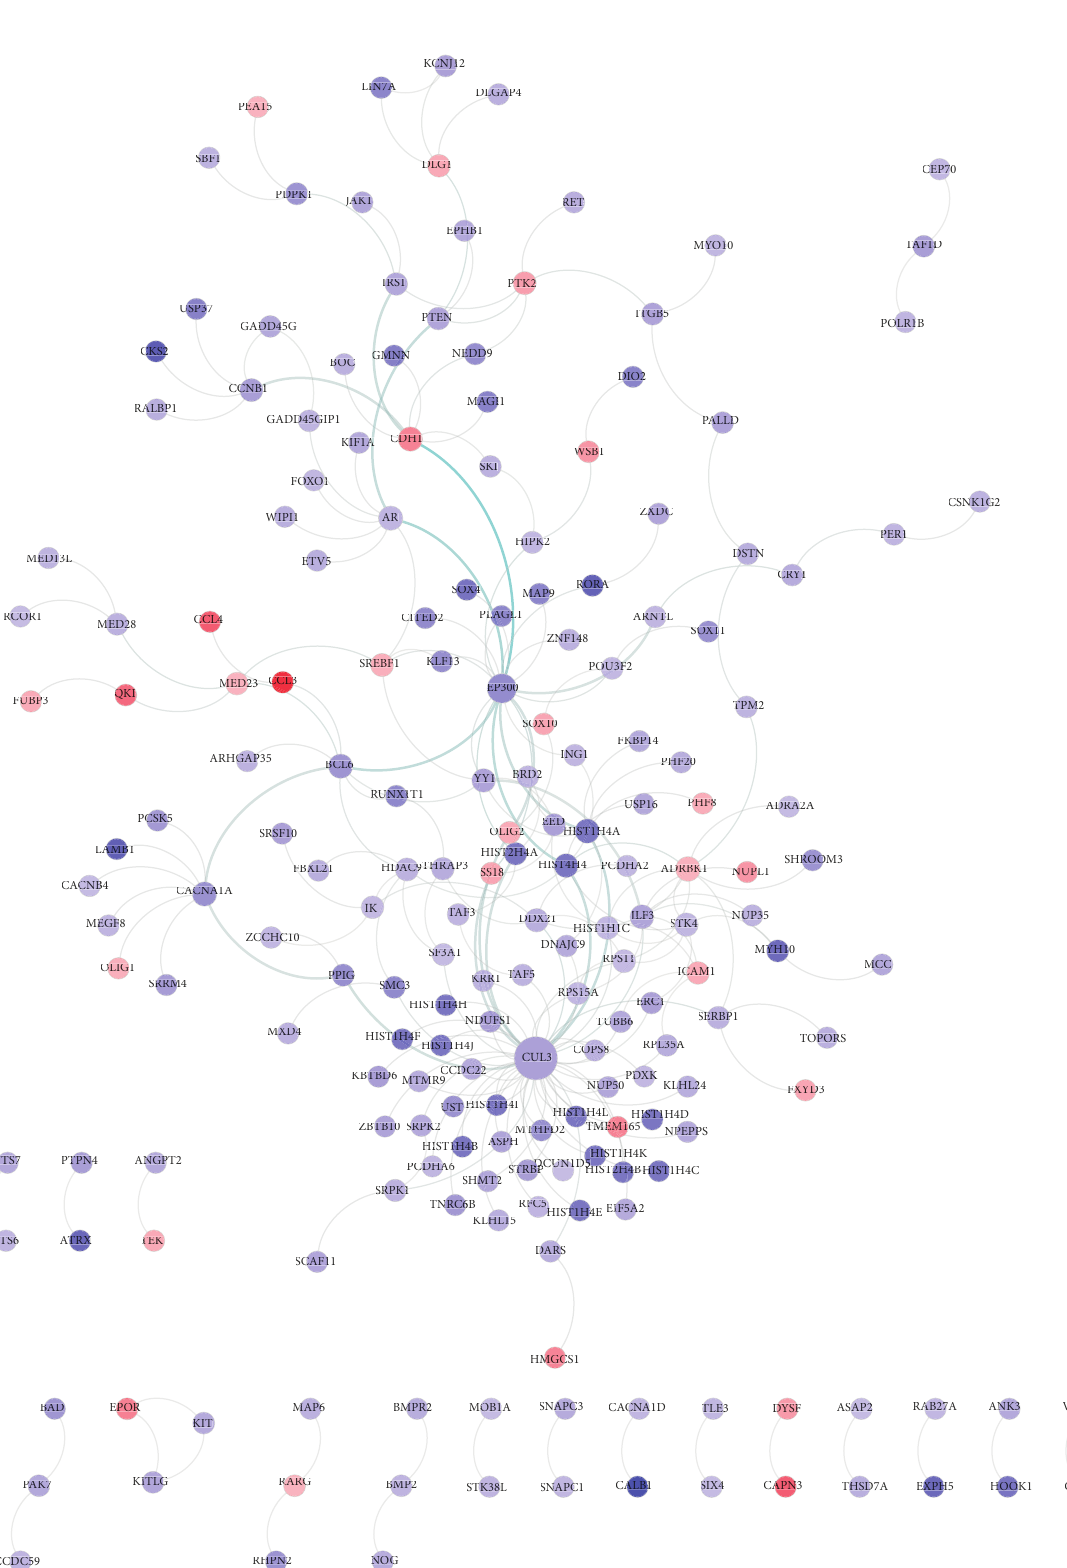
Figure2:Interactionnetworkconstructedwithproteinsencodedbyselectedgenes.Proteinswithmorelinksareshowninbiggersize.Proteins shown in red are encoded by overexpressed genes in patients while those in blue are encoded by depressed genes in